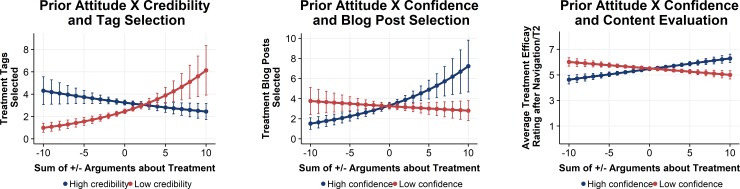
Overview of interaction effects.